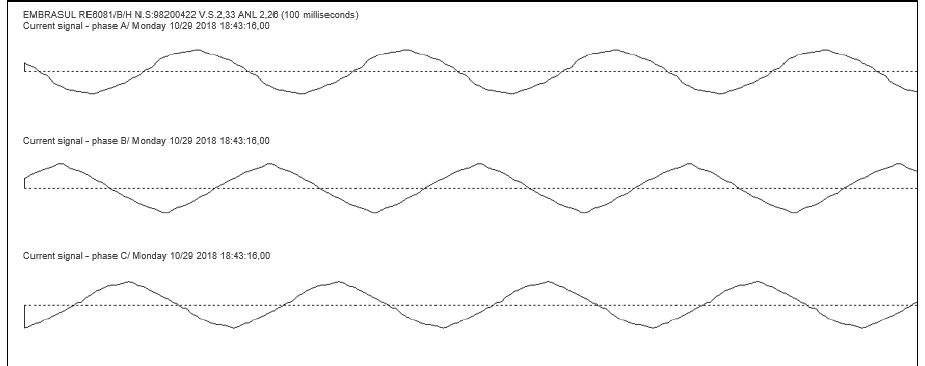
Figure 9: Current output from UPS